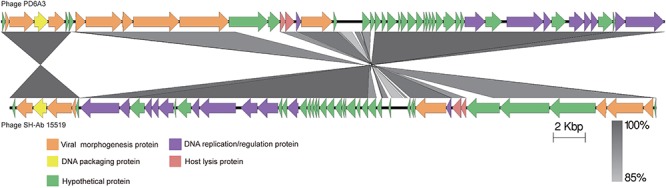
The comparison of the complete genome sequence of the Phage PD6A3 using Easy fig against the closet homolog phage SH-AB15519. The colored arrows indicate ORFs according to their predicted function. The homologous regions between phages are indicated by gray shading.